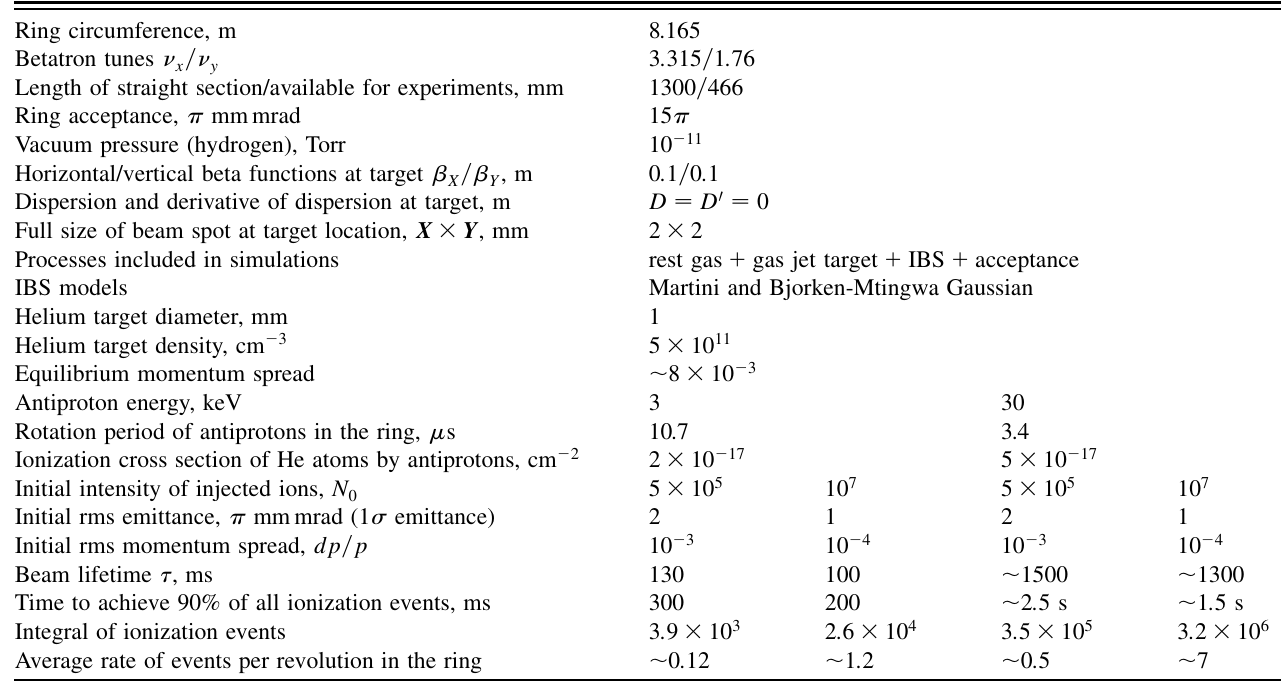
TABLE III. Overview of the recycler ring parameters Ring circumference, m